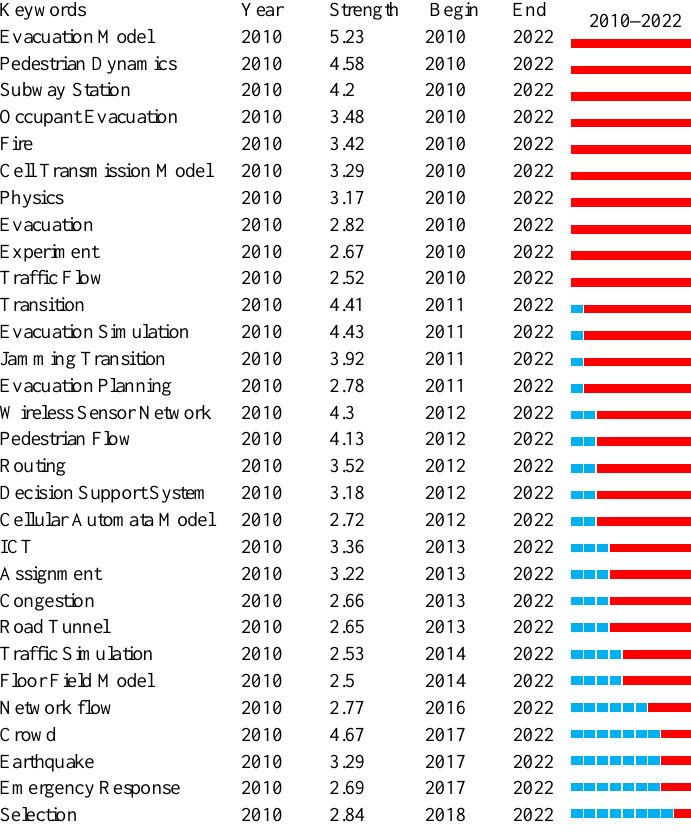
Figure 8. Top 30 keywords with the strongest citation bursts.